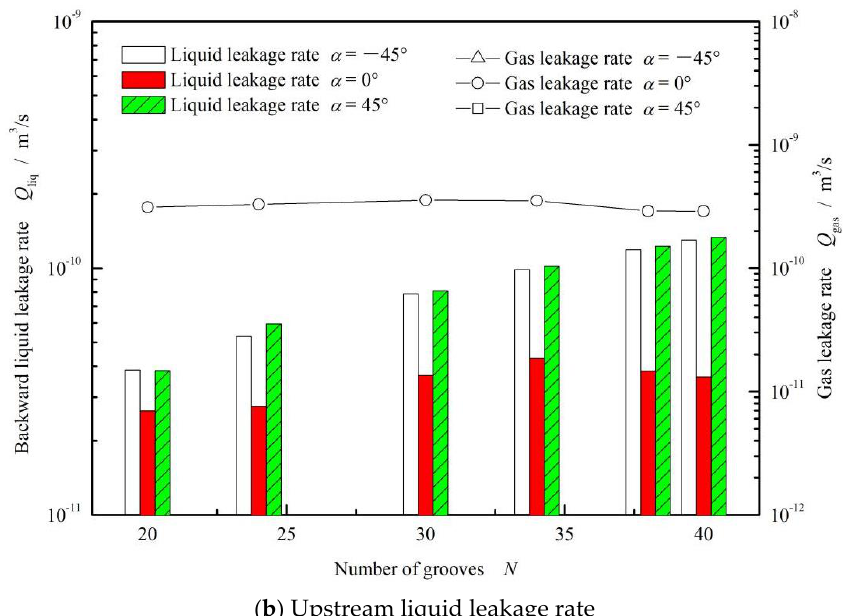
Figure 9. Effect of number of grooves on the opening force ( a ) and leakage rate ( b ). ( ω = 10,000 rpm, p o = 0.3 MPa, h 0 = 2 μm and γ = 3.5). p o = 0.3 MPa, h 0 = 2 µ m and γ =